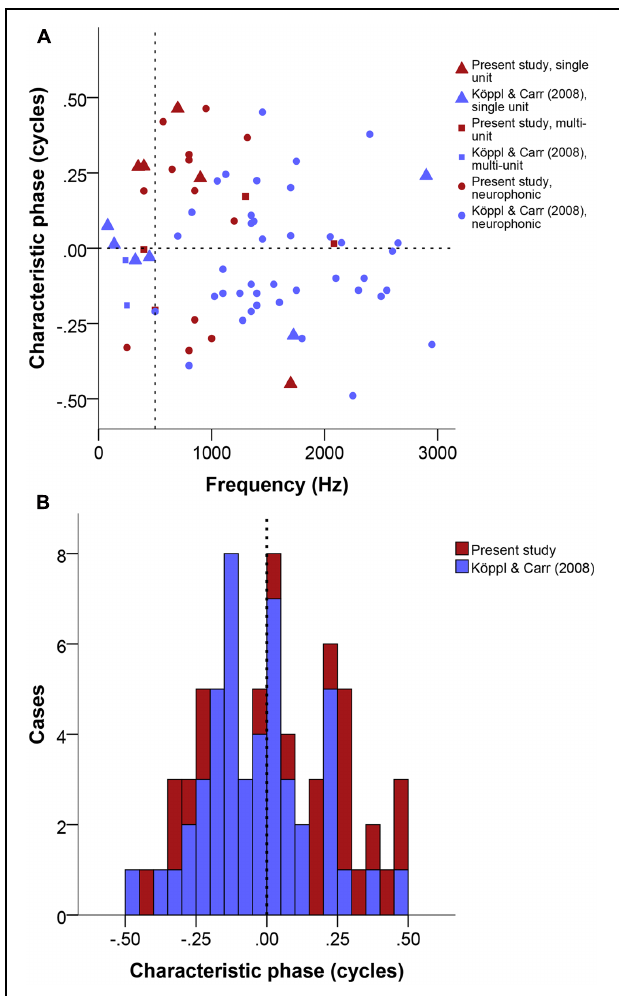
FIGURE 7 | Characteristic phase (CP) normalized to a single cycle ( ± 0.5). (A) CP in cycles as a function of stimulus frequency (Hz). Triangles represent single unit recordings, squares represent multiunit recordings and circles represent neurophonics.The horizontal dashed line marks the acoustic midline at 0 µ s ITD and the vertical dashed line marks the 500 Hz position. (B) Stacked histogram of CP normalized to one cycle. Bins are 0.05 cycles wide. The dashed line marks the zero position. Data shown in red are from the present study, data shown in blue from Köppl and Carr (2008).